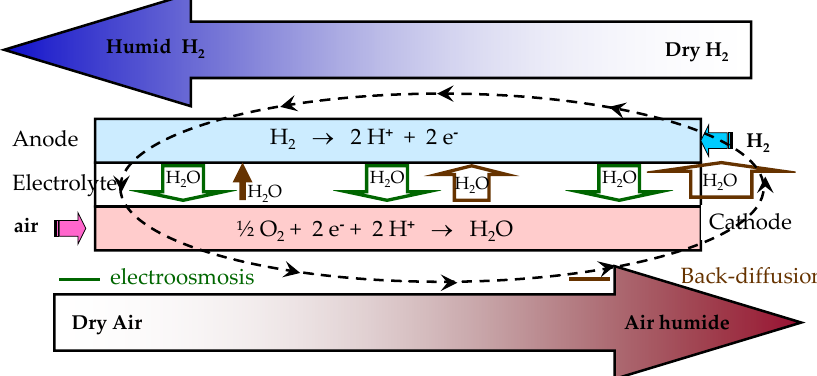
Figure 15. Principle of homogenization of the water content in the PEMFC MEA.